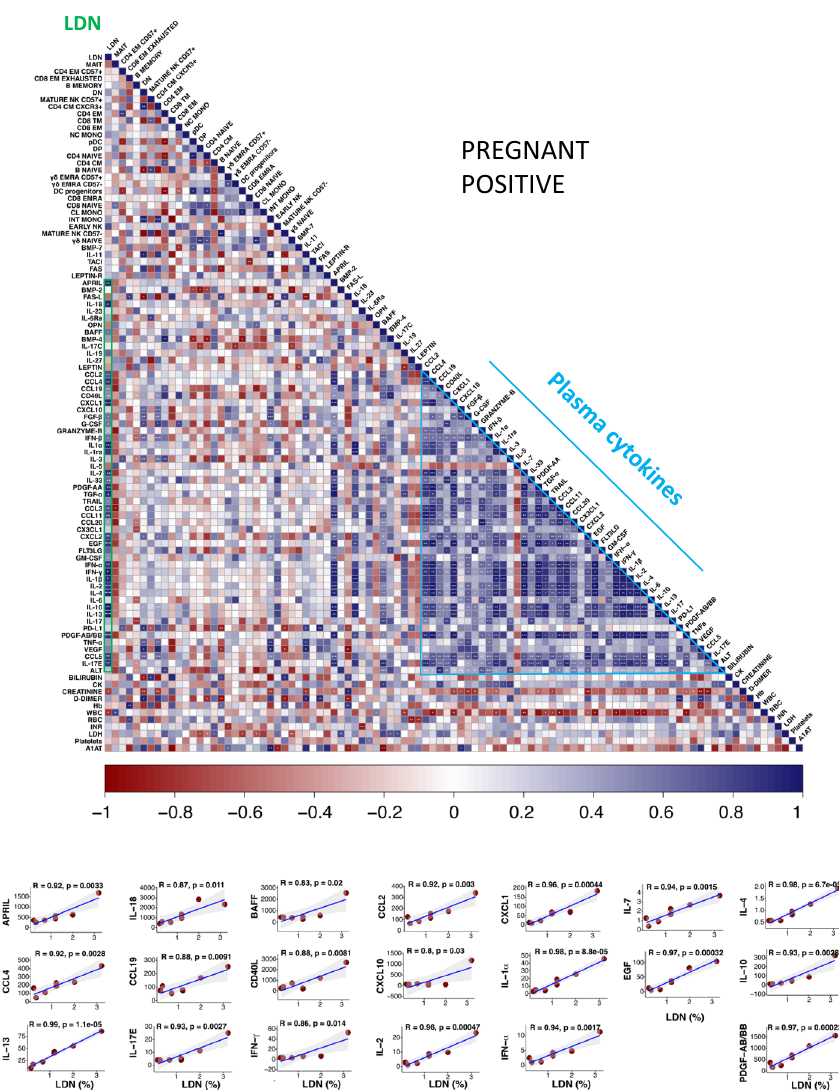
Fig. 9 Correlogram showing the role of LDN in infected women, and the correlations among plasma cytokines. Correlogram of pregnant positive women (PP). Spearman R ( ρ ) values are shown from red ( − 1.0) to blue (1.0); speci fi c R values are indicated by the square color. Blank fi elds with dots indicate lack of signal. Spearman rank two-tailed p -value was indicated by * P < 0.05, ** P < 0.01, and *** P < 0.001. Additional XY scatter plots, that speci fi cally show the relationship between the variables that are most correlated with LDN, are displayed. Each scatter plot reports the regression line (blue), the Spearman R ( ρ ) value, the exact two-tailed p -value and the 95% con fi dence bands (light gray). All cytokines value are referred as pg/ml. PDGF-AB/BB refers to the ratio between the forms AA and AB of the platelet-derived growth factor